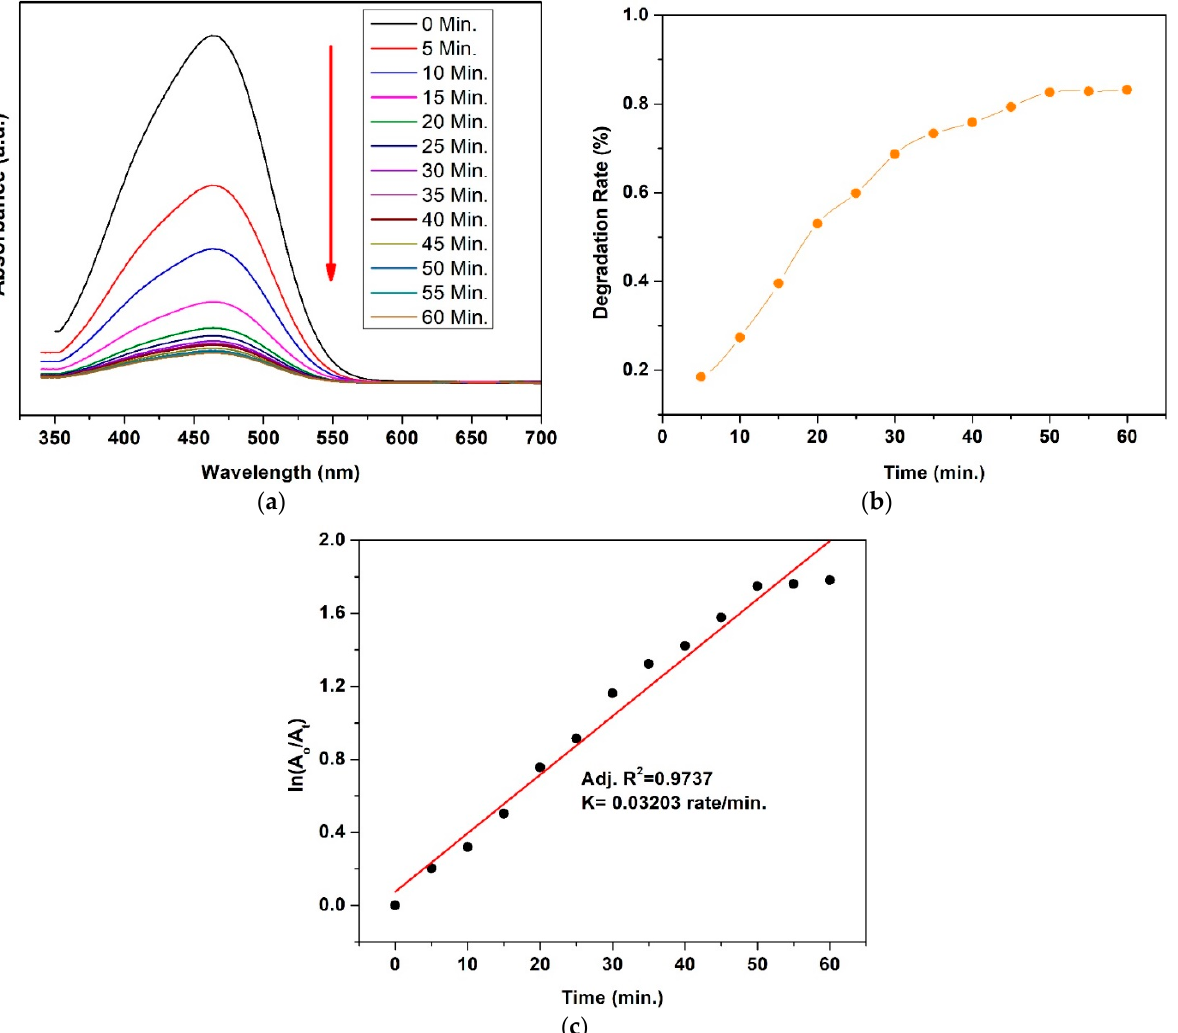
Figure 11. Photocatalytic activity of MO in presence of Co 0.4 Cu 0.6 Fe 2 O 4 nanoparticles irradiated by visible light for 60 min: ( a ) UV–Vis. Spectra, ( b ) Degradation rate in % and ( c ) kinetics of degrada ‐ tion.